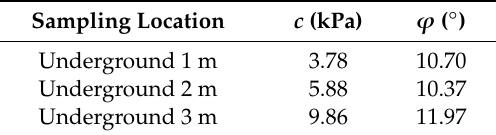
Table 2. Test results of direct shear.